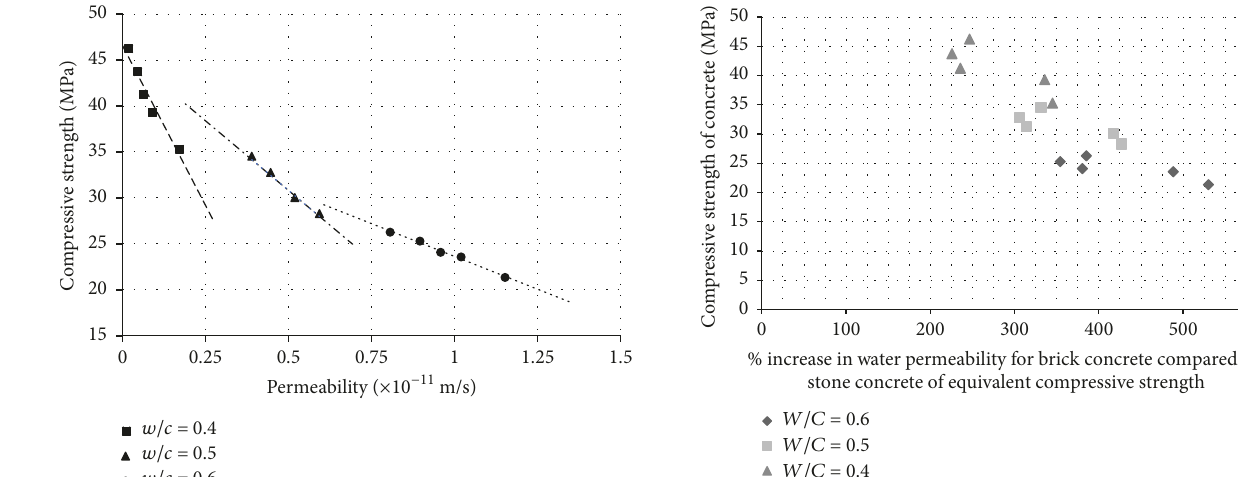
Figure2:Waterpermeabilitycoefficientwithrespecttocompressive strength of stone aggregate concrete.